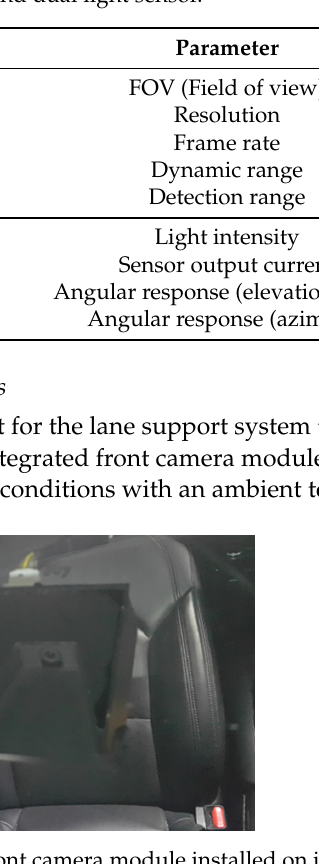
Table 2. CMOS sensor and dual light sensor.